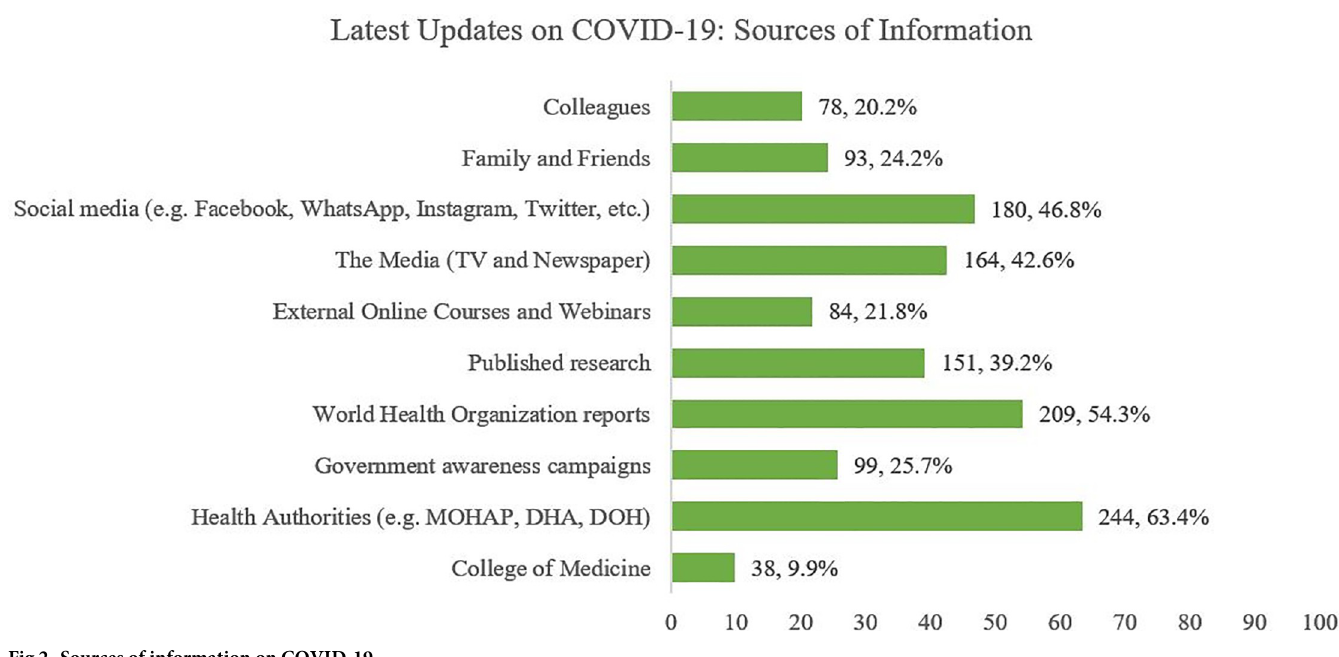
Fig 2. Sources of information on COVID-19.